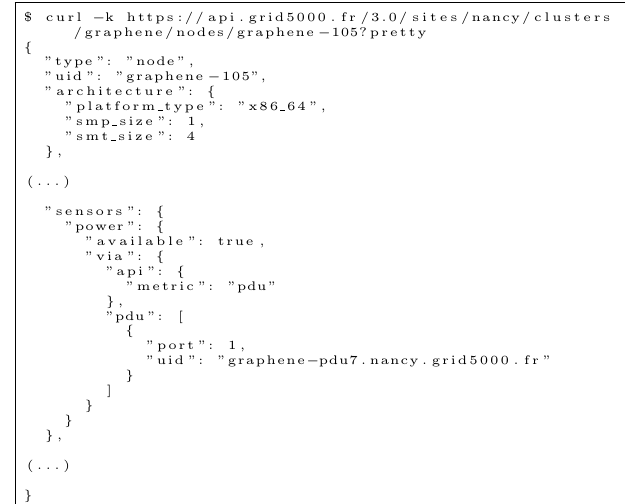
Figure 4: Description of a Energy Monitoring Fea- ture of a Power Distribution Unit in Grid’5000 Ref- erence API